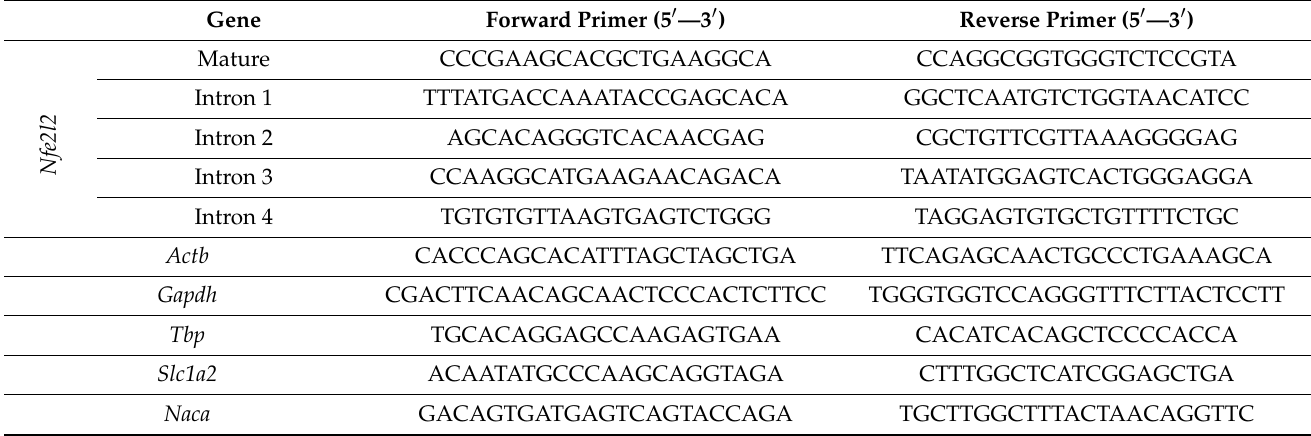
Table 3. qPCR primers used throughout the